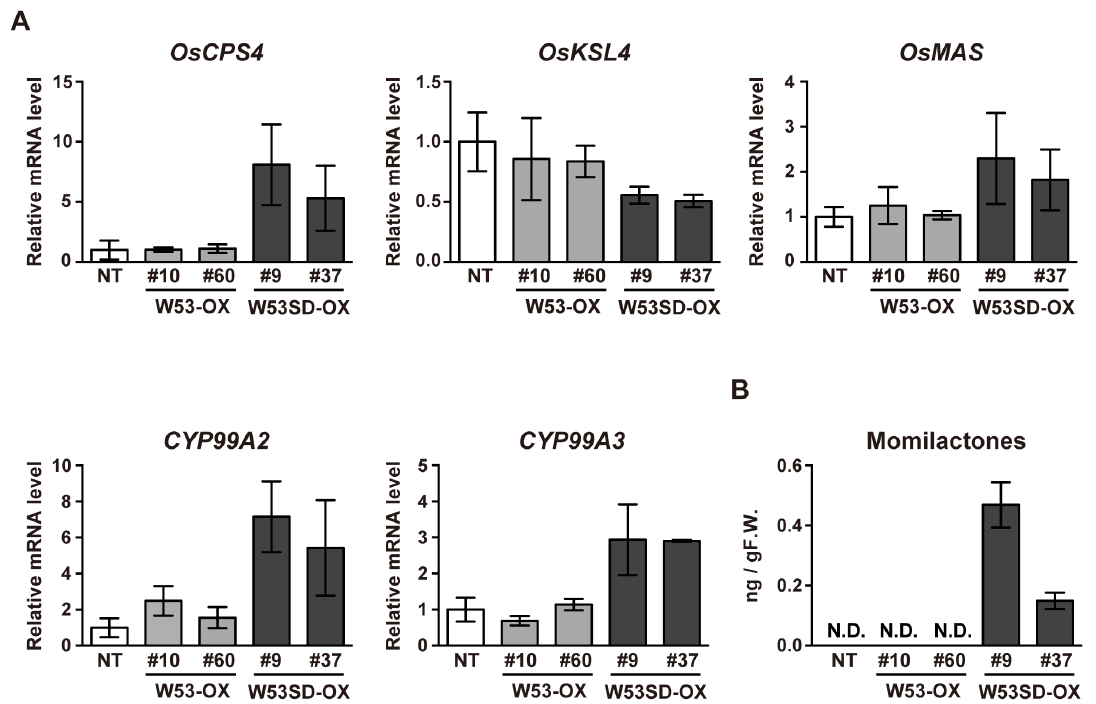
Figure 6. Phytoalexin accumulation in W53SD-OX rice plants. A , Expression analysis of momilactone biosynthetic genes. qRT-PCR analysis was performed using total RNA isolated from uninfected rice leaves. Values indicate relative mRNA levels normalized to the expression of the UBQ gene (n=3); bars indicate the standard error of the mean. Three independent experiments were performed, and a representative result is shown. B , Accumulation of momilactones in uninfected W53SD-OX rice plants. Momilactone levels in the rice leaves were determined by LC-MS/MS. The results are the average of at least 3 independent experiments. Bars indicate the standard error of the mean. NT, non-transformed control; OX, OsWRKY5 3- overexpressing rice plants; SD-OX; OsWRKY53SD -overexpressing rice plants. N.D.: not detected.